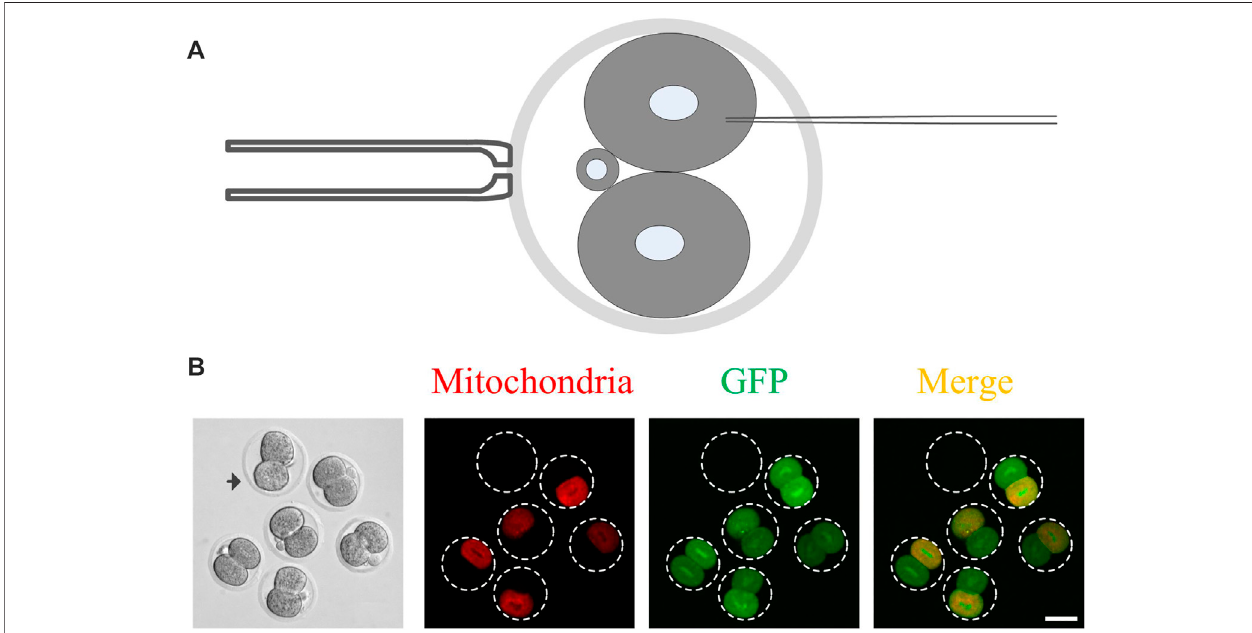
FIGURE1 | The cytoplasmic GFPbutnot theRFP-labeledmitochondria can be transportedbetween thedaughtercells in 2-cellmouse embryos. (A) Aschematic of mRNA microinjection. The 2-cell embryo is held vertically by a holding pipette so that the microinjection pipette can completely avoid another daughter cell. Only one random daughter cell was microinjected with mRNA; (B) Representative images of the cytoplasmic communication. The cytoplasmic GFP but not the RFP-labeled mitochondria were transported from one daughter cell to another daughter cell. After 4 h of the mouse embryo, which morphologically divided into two cells, the mRNA expressing GFP and mitochondrial localized RFP was microinjected into it and images were captured 15 h later. The arrowhead indicates the control embryo, which was added in the samples to eliminate auto fl uorescence leading to false-positive results with weak fl uorescence. Scale bar (cid:1) 50 μ